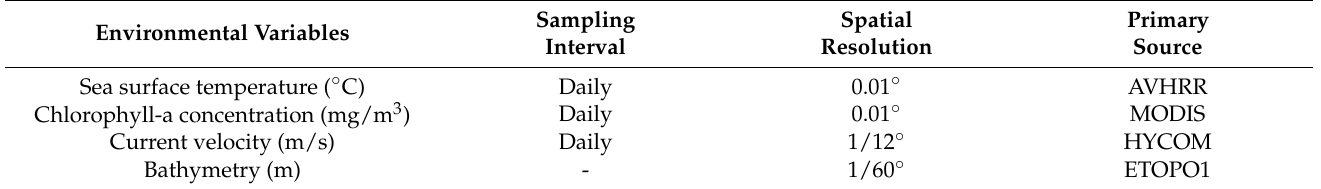
Table 1. Environmental parameters used to construct habitat model for black sea bream in coastal waters of Taiwan. Sampling Environmental Variables Interval